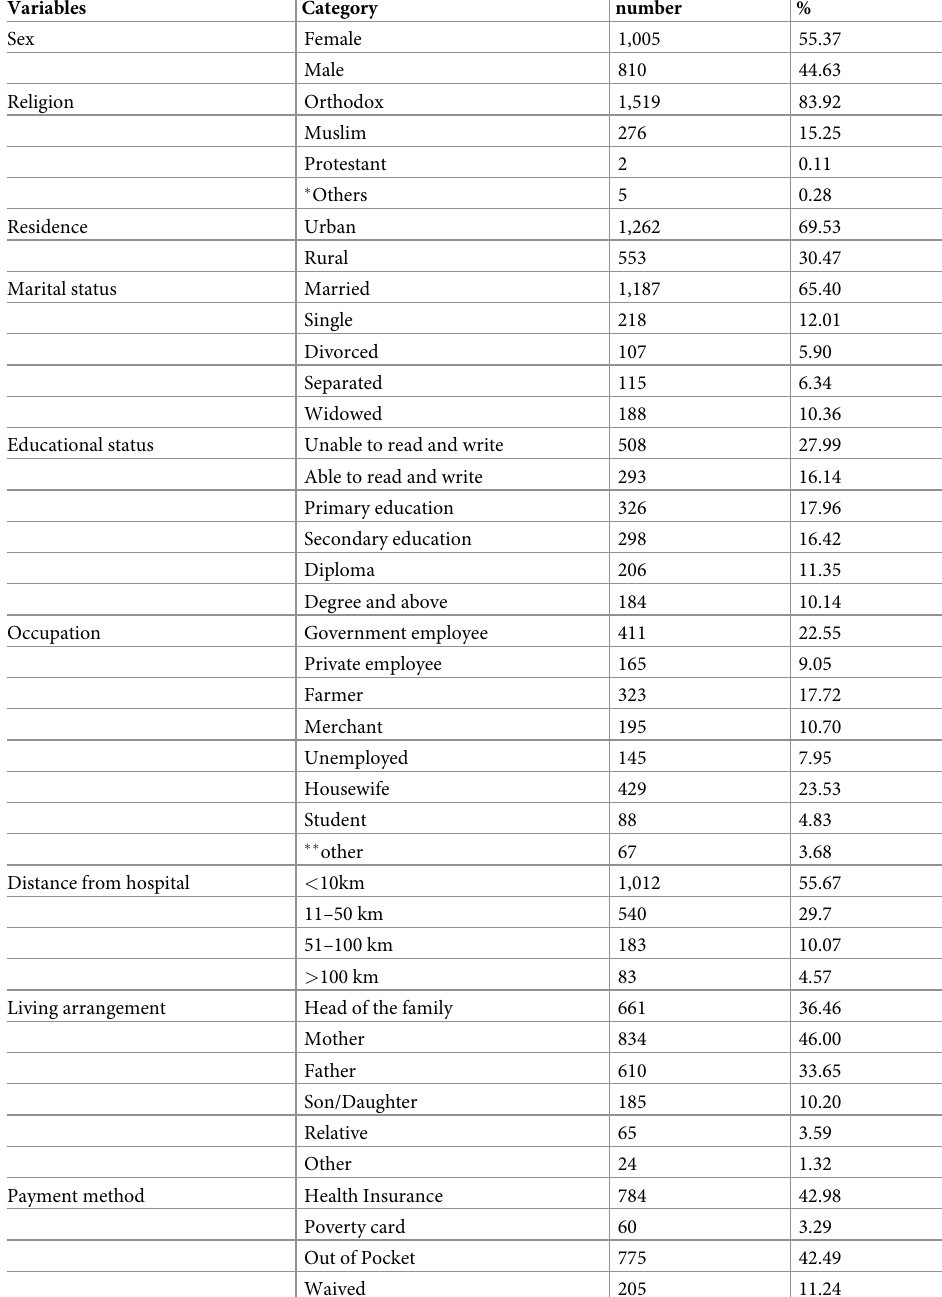
Table 1. Background characteristics of patients with common chronic diseases in Amhara region, Ethiopia, 2021.